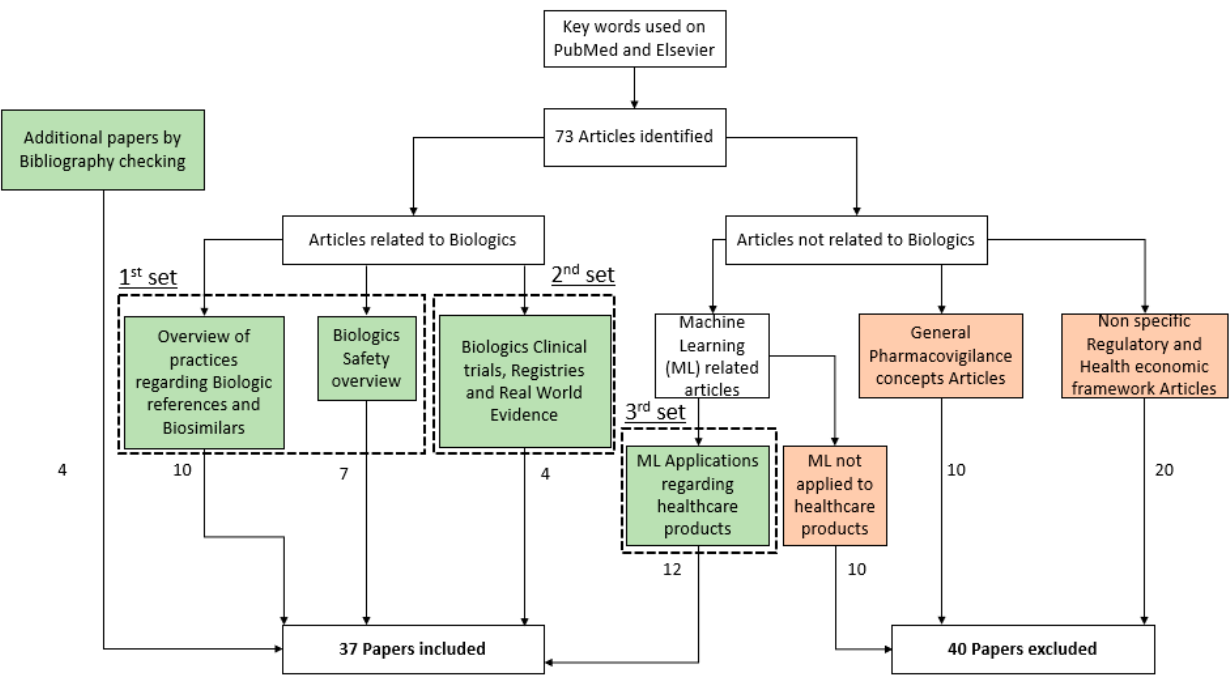
Figure 1. Inclusion and exclusion of identified articles.